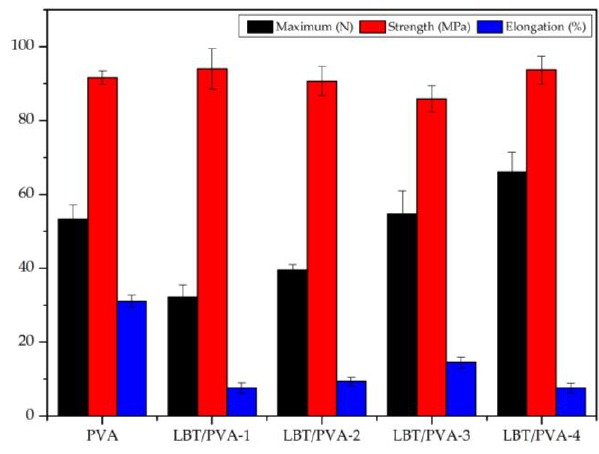
Figure 6. Mechanical properties of the composite membranes.